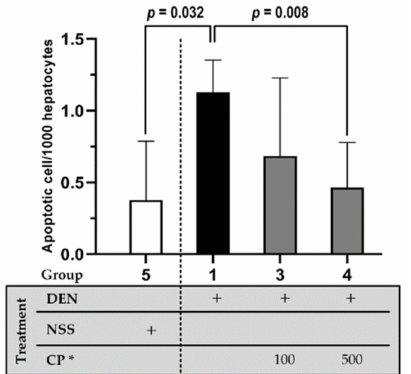
Figure 5. The effect of CP on apoptotic cell expression as indicated using TUNEL assay. DEN or NSS were initially administered at week 0 and 1. Then either DW (for groups 1 and 5) or CP were fed weekly starting from week 2 till the end of the experiment. Data displays non-normal distribution (Shapiro-Wilk and Levene’s test: p < 0.05) and was analyzed for statistical difference using nonparametric Mann Whitney U test. * CP dosage unit; mg/kg